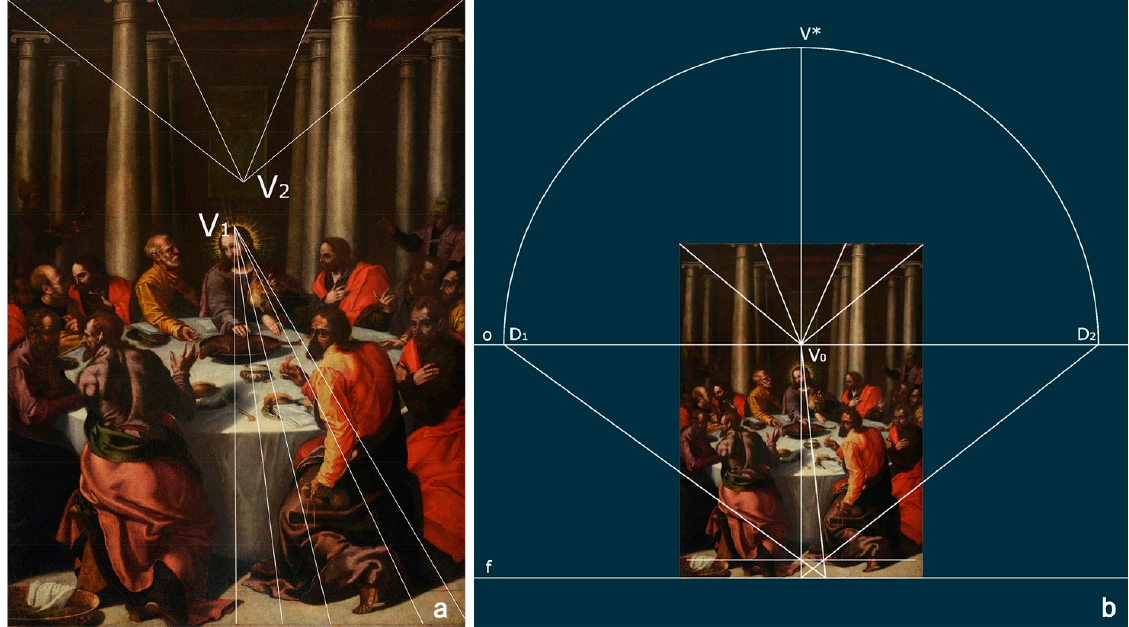
Figure 5. ( a ) Depth lines not converging in a single point; ( b ) identification of the essential elements of the perspective.